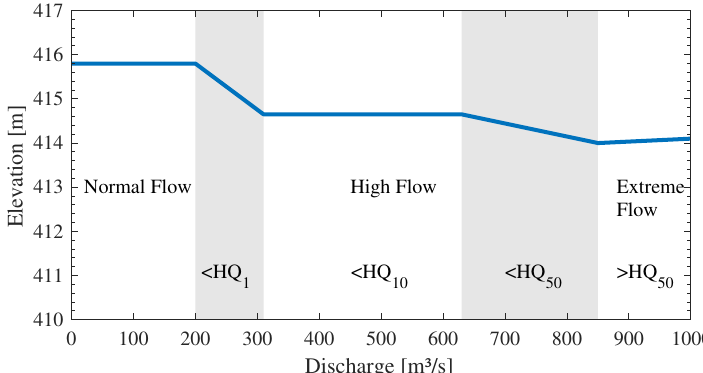
Figure 2. Simplified sketch of the HPP Rott: ( a ) top view, with the upstream reservoir, the weir with gates, and the orographically left located power house with the turbine intake; and ( b ) longitudinal section through one of the weirs.